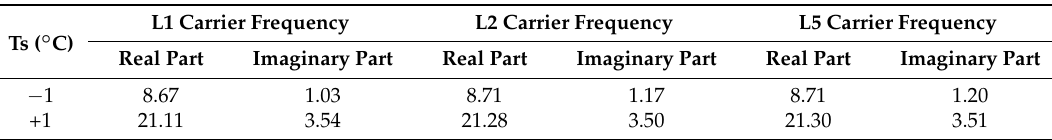
Table 1. Permittivities (both real part and imaginary part) for GPS L1, L2 and L5 bands. The soil temperature is changed from − 1 ◦ C to 1 ◦ C.